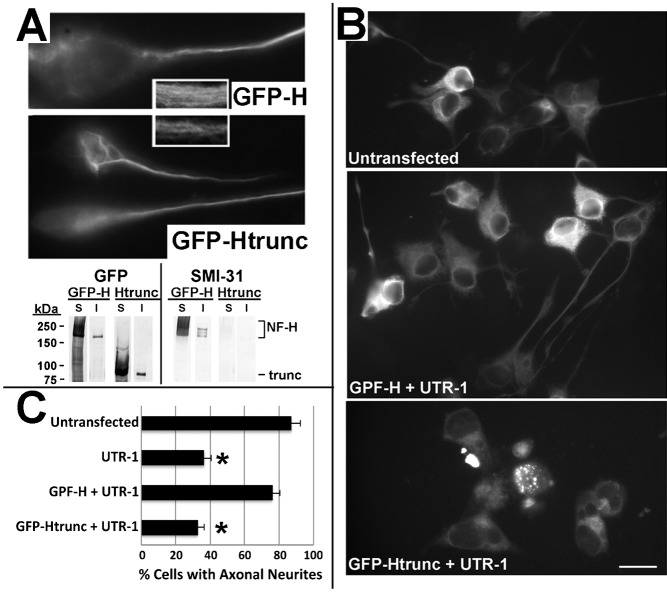
The C-terminal sidearm mediates rescue of axonal neurites by exogenous NF-H.(A) Representative epifluorescent images of differentiated cells and immunoblot analysis of Triton-soluble (S) and Triton-insoluble (I) fractions derived from cells transfected 48 hr previously with GFP-H or GFP-Htrunc as indicated. Inserts present a higher-mag of axonal NFs. Note that GFP-Htrunc is observed within filamentous profiles within axonal neurites and is recovered within the Triton-insoluble cytoskeleton. Nitrocellulose replicas were probed with anti-GFP and the NF C-terminal-specific antibody SMI-31. As anticipated, GFP-Htrunc lacks immunoreactivity with SMI-31 due to absence of the C-terminal sidearm. (B) Representative immunoflourescent images of NF-H in differentiated cells without transfection or co-transfected with UTR-1 and either GFP-H or GFP-Htrunc as indicated. (C) Quantification of the percentage of cells with axonal neurites without transfection or following transfection with UTR-1 without or with co-transfection with GFP-H or GFP-Htrunc. UTR-1 significantly reduced the number of cells with axonal neurites; as above (Fig. 4), co-transfection with GFP-H prevented this reduction, while GFP-Htrunc was unable to prevent this reduction (p<0.01 for both UTR-1 vs untransfected cells and UTR-1 + GFP-Htrunc vs untransfected cells; ANOVA with Fischer's post-hoc analyses). Bar: 25 µm.